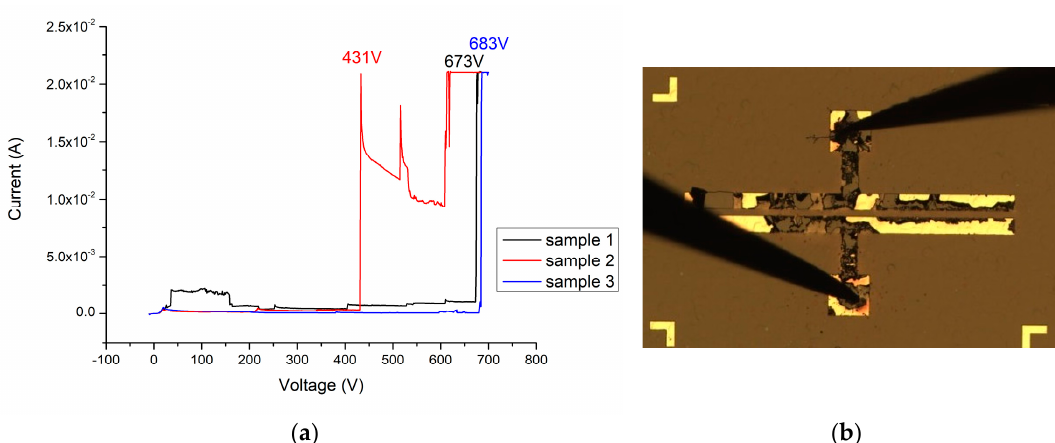
Figure 21. ( a ) I–V measurement results (sample 1 in black, sample 2 in red, and sample 3 in blue) and ( b ) breakdown image of the MOSOM varactor (with a 156 nm thick Ga 2 O 3 thin film) without the annealing process.